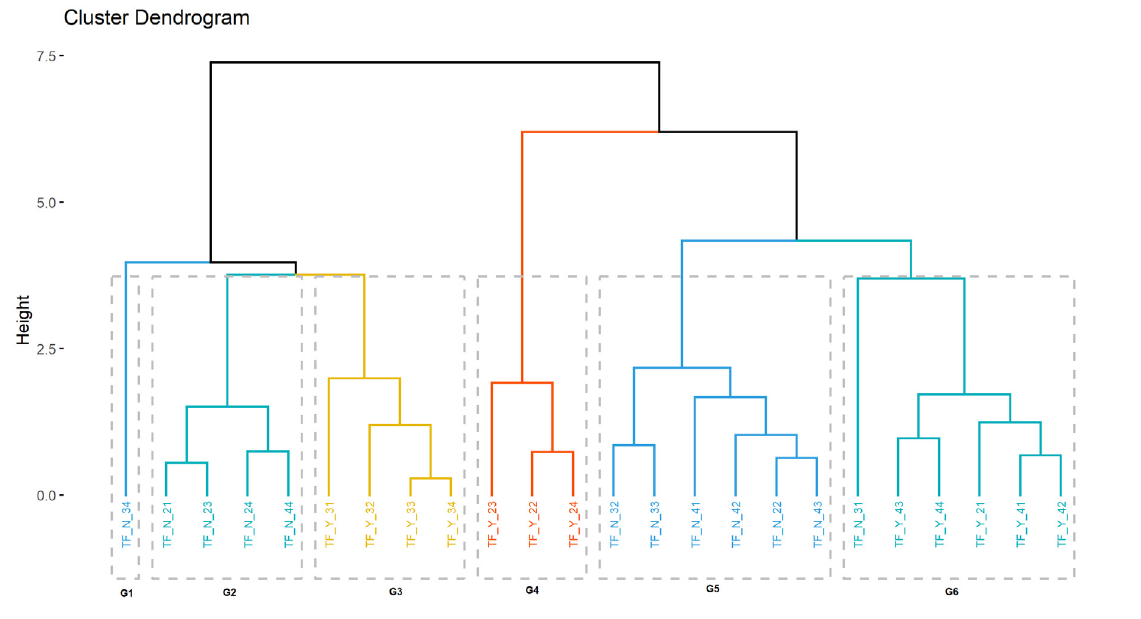
Figure 5: Cluster analysis grouped in six groups. Cultivar Touriga Franca without kaolin – TF_N, Touriga Franca with kaolin – TF_Y. The first digit refers to the days after application (DAA). 2: DAA 44; 3: DAA 57; 4: DAA 85 and the second digit is the repetition number (1-4). The letter G refers to the group aggregation (1-3) of the cluster